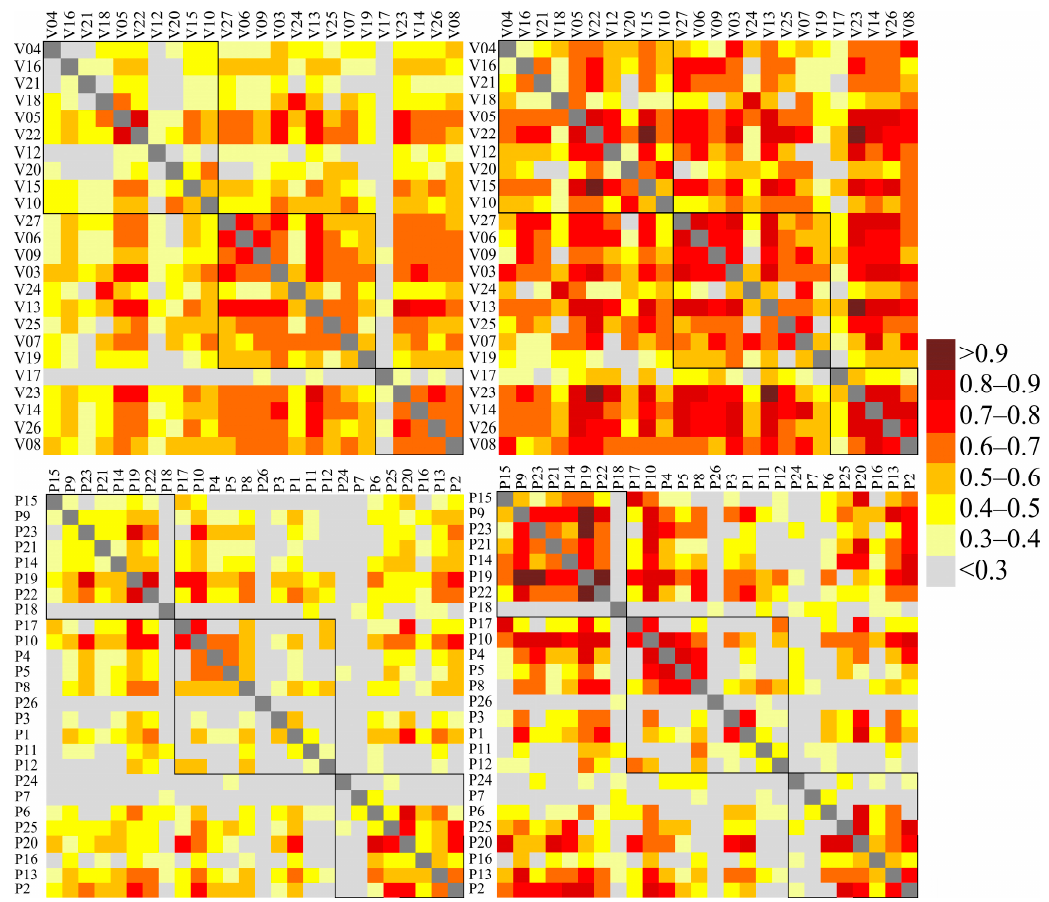
Figure 4. Pearson correlation coefficient between Speck PM monitors calculated from hourly ( left ) and daily ( right ) PM averages, and from the 1st period ( top ) and 2nd period ( bottom ). LOD uncorrected data only were considered. The black squares denote groups of measurement sites geographically similar to each other.